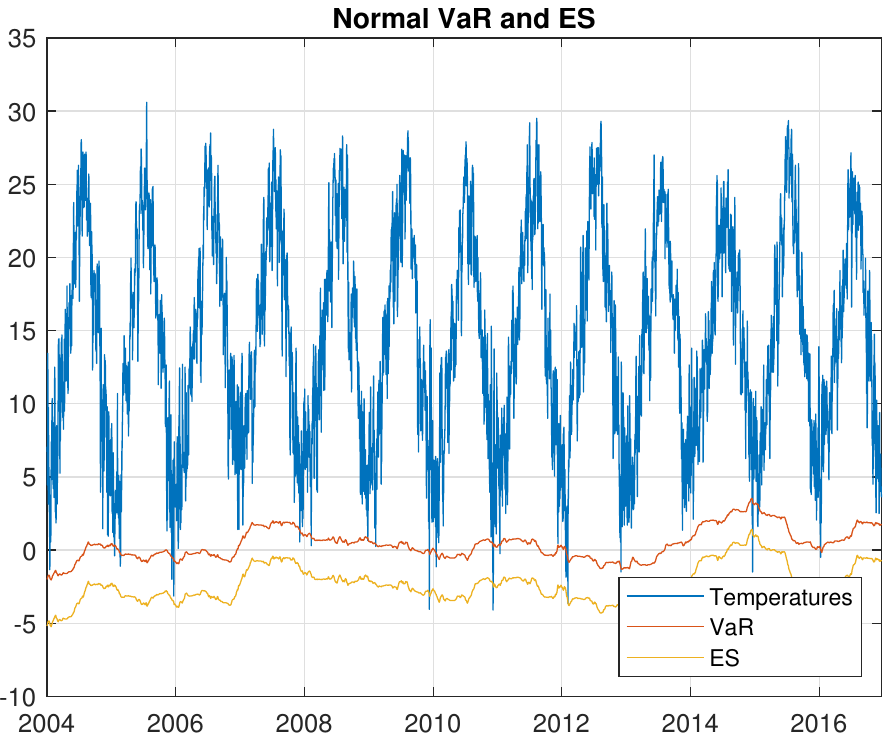
Figure 6. The daily average temperature, VaR, and ES estimated with the normal method.